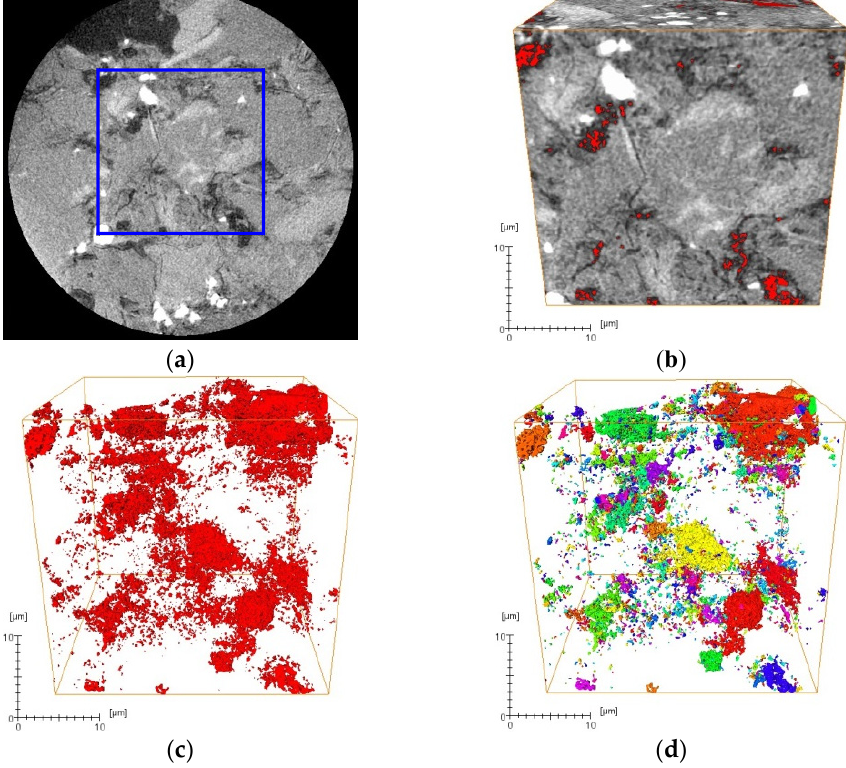
Figure 7. Pore extraction steps using the nano–CT. ( a ) 2D slice; ( b ) 3D reconstruction of pore image; ( c ) pore distribution; ( d ) connectivity of the pores. In Figure 7d, each color signals a pore not connected to the others.